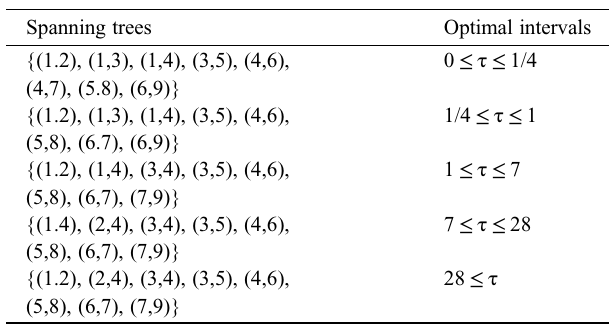
CTP optimal spanning trees for Example 4 (Vasko et al., 2002) Spanning trees Optimal intervals